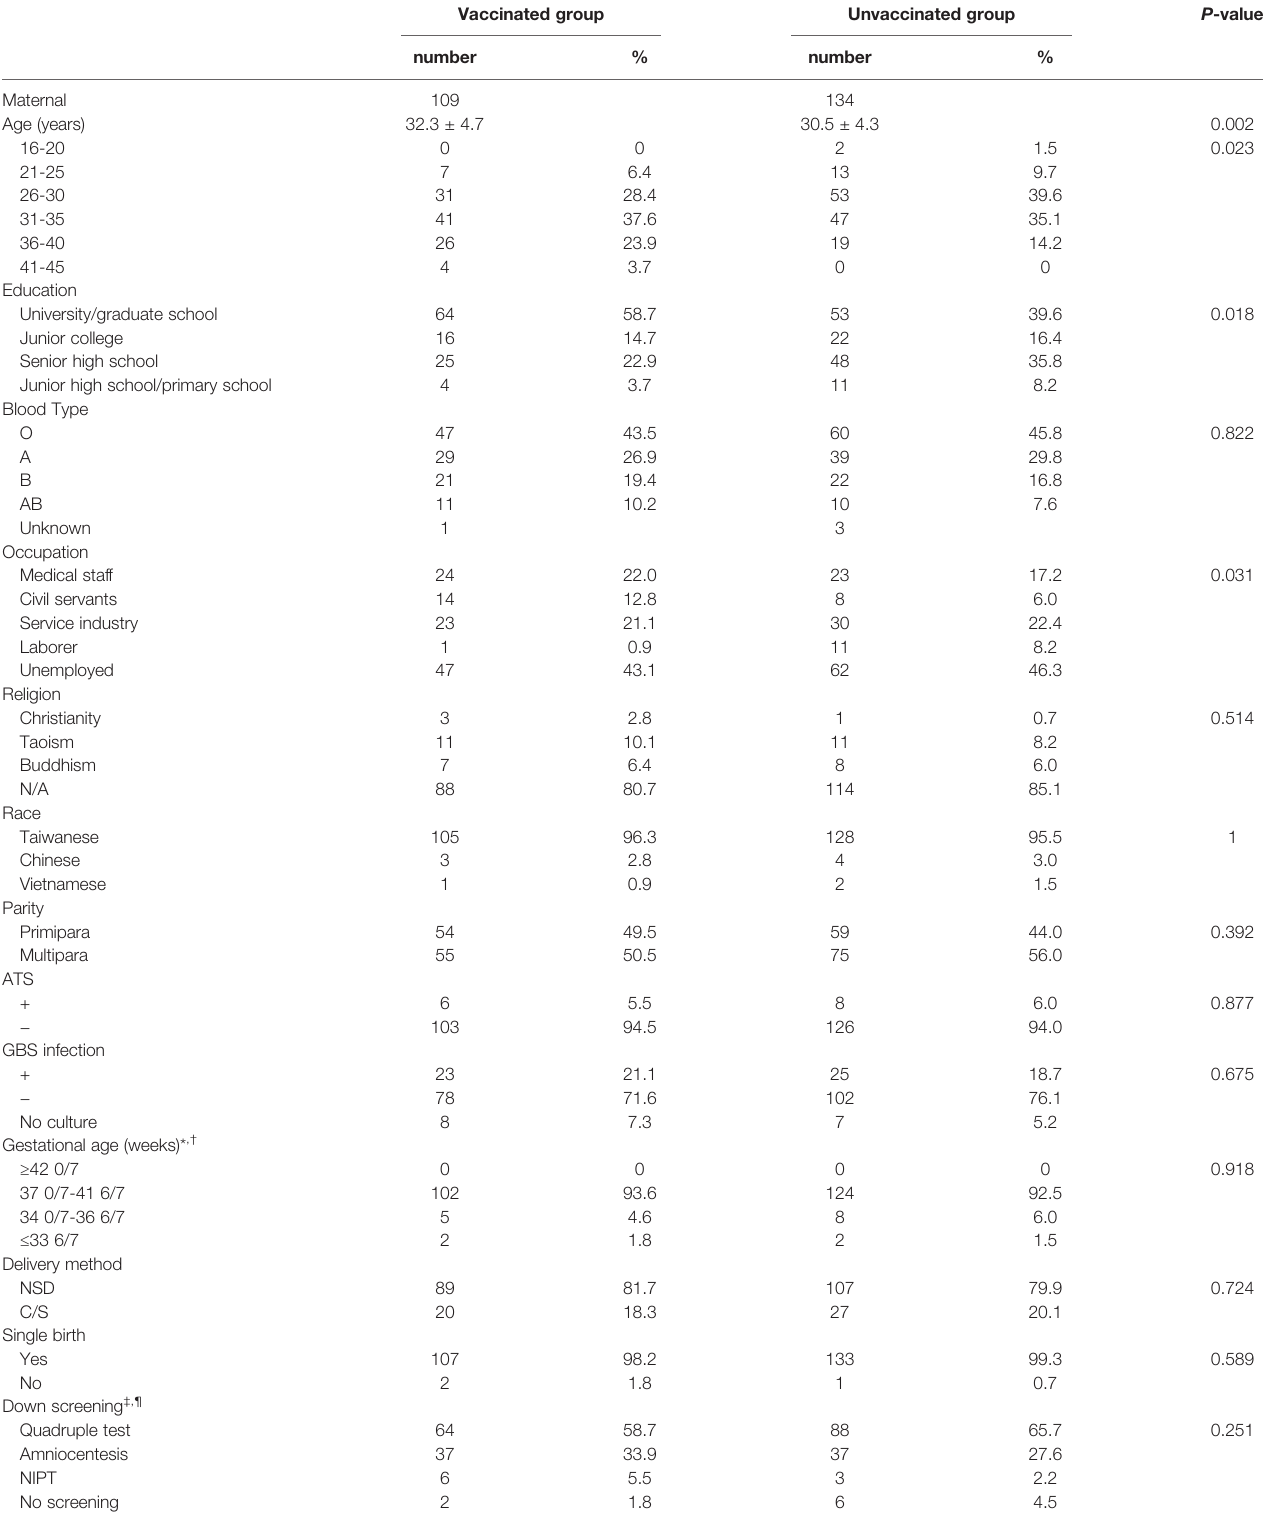
TABLE 1 | Characteristics of maternal and newborn between vaccinated and unvaccinated groups.